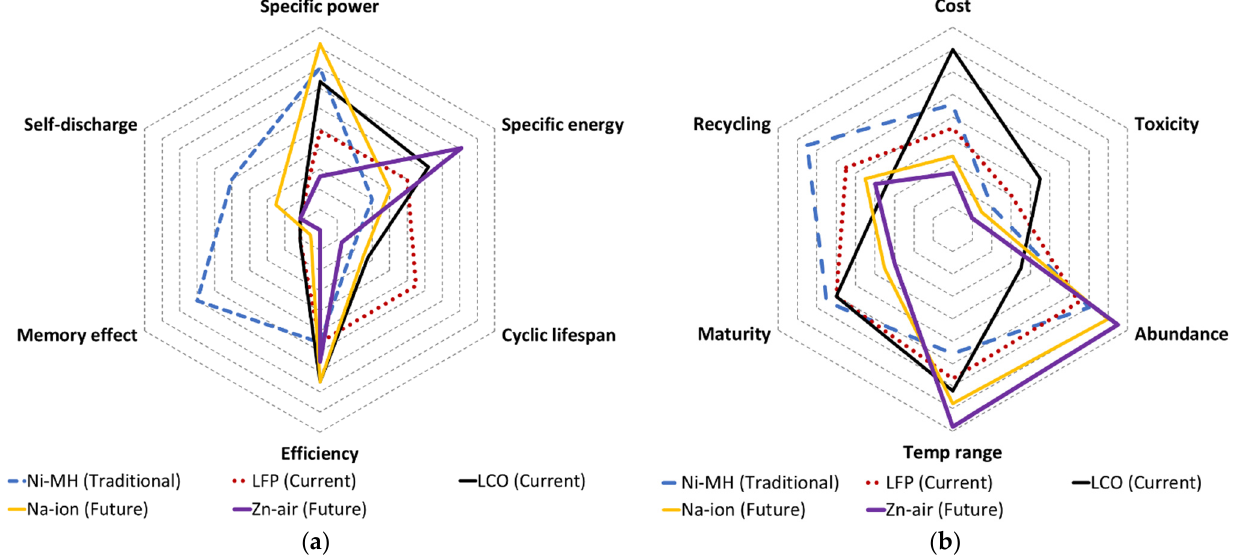
Figure 12. Generation-wise comparison among batteries for EV applications. ( a ) Key performance indicators. ( b ) Key design markers.